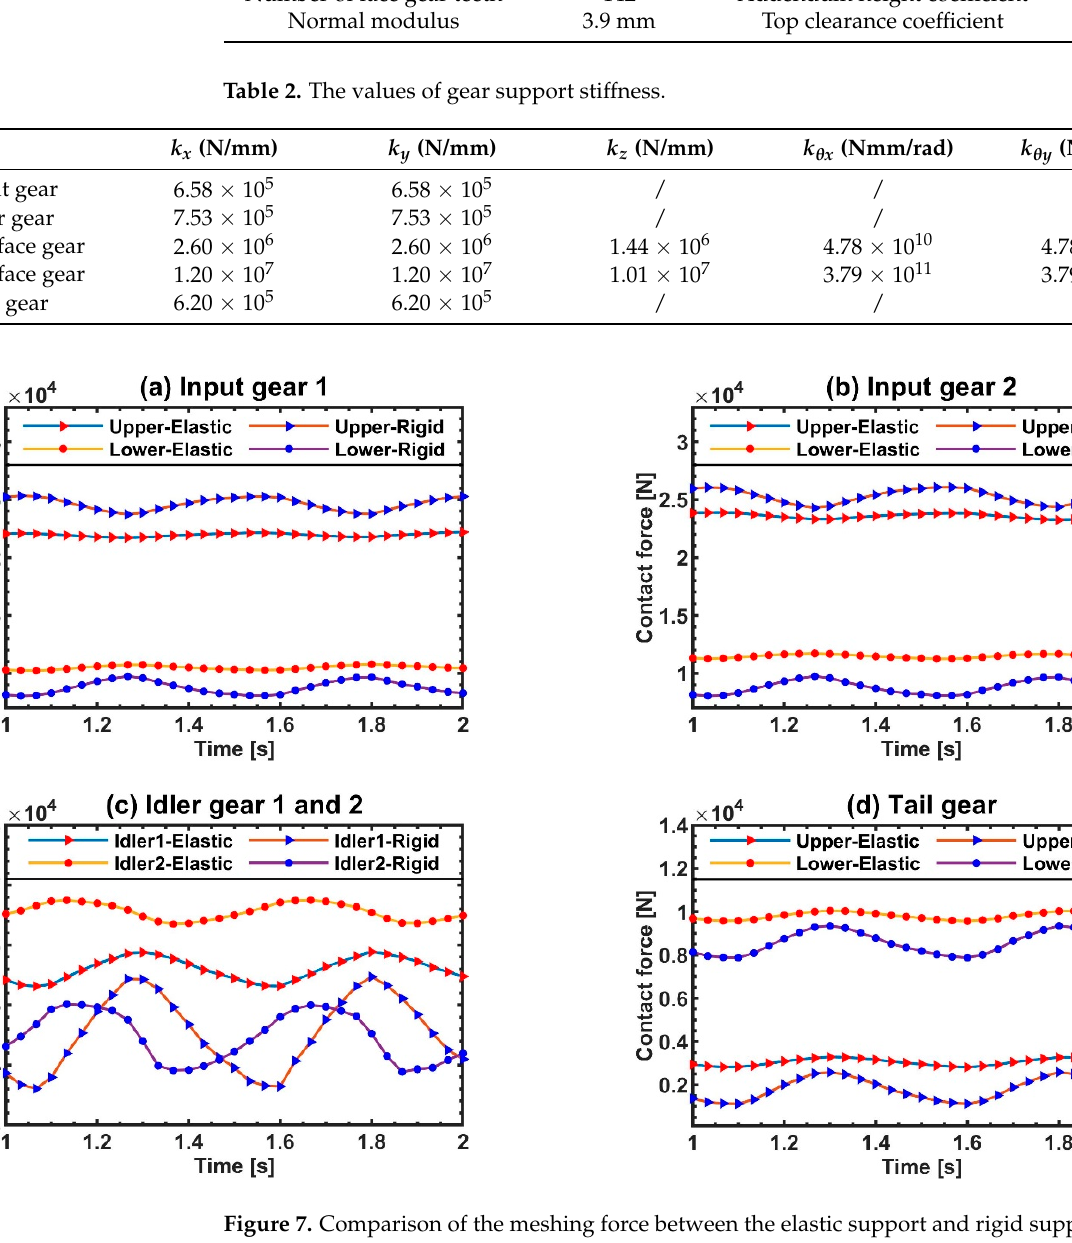
Figure 7. Comparison of the meshing force between the elastic support and rigid support.